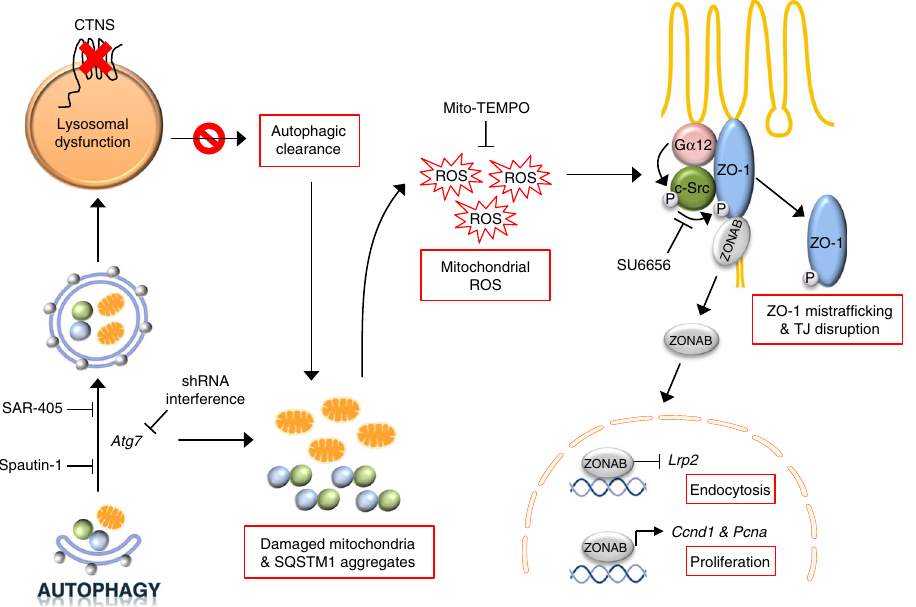
Fig. 10 A working model depicting the link between defective lysosome – autophagy pathways and epithelial dysfunction in cystinosis. The black arrows identify the sequence of events occurring within cystinosis PT cells. The loss of the cystinosin (CTNS) transport system leads to lysosomal dysfunction. This impairs the cellular clearance of autophagosomes containing SQSTM1 + aggregates and/or damaged mitochondria. Similarly, pharmacological and genetically mediated failure of autophagy (with SAR-405 and Spautin-1 inhibitors or with shRNA-mediated knockdown of Atg7 ) increases the SQSTM1 + aggregates and/or damaged mitochondria-producing ROS. The mitochondrial oxidative stress enables the G α 12/Src-mediated phosphorylation of the tight junction adapter protein ZO-1, resulting in its misrouting to endolysosomal compartment. The disruption of tight junction integrity releases the ZO-1- associated Y-box factor ZONAB, which promotes cell proliferation and represses apical endocytic receptors such as LRP2, causing epithelial dysfunction in PT cells. Conversely, neutralization of excessive mitochondrial oxidative stress (with mitochondria-targeted oxygen scavenger Mito-TEMPO) or blockade of the G α 12/Src regulatory loop (with a selective Src-kinase inhibitor Su6656) restores the differentiation and transport properties in cystinosis PT